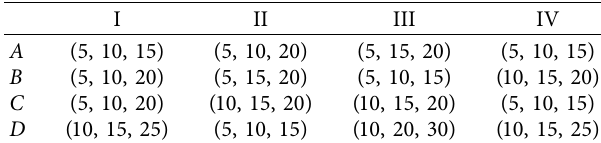
Table 6: Example 2.